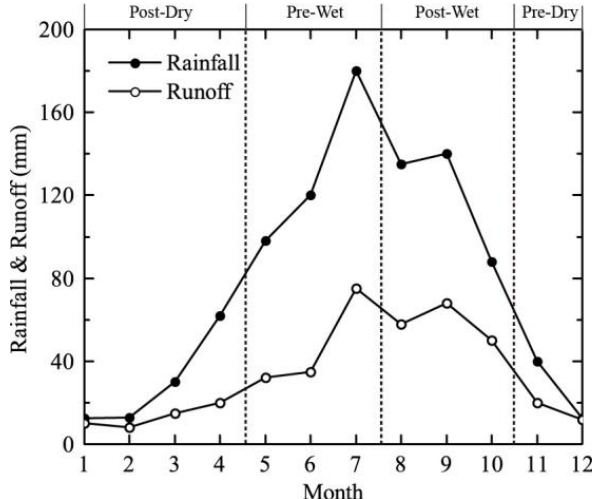
Fig. 2. Rainfall and runoff regimes over upper Hanjiang River basin Figure 2. Rainfall and runoff regimes over upper Hanjiang River basin (UHRB). Runoff is the 595 (UHRB). Runoff is the total amount of monthly inflow (m 3 ) to Dan- jiangkou reservoir divided by basin area (km 2 ). Rainfall is the mean total amount of monthly inflow to Danjiangkou reservoir divided by basin area. Rainfall is the 596 value of all the rain gauges weighted by area. The unit is in mm. mean value of all the rain gauges weighted by area. The unit is in mm . 597